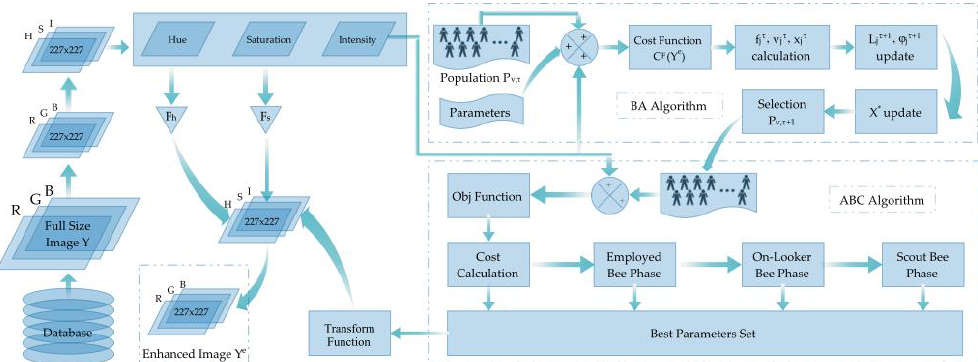
Figure 3. BA-ABC contrast-stretching and transformation flow